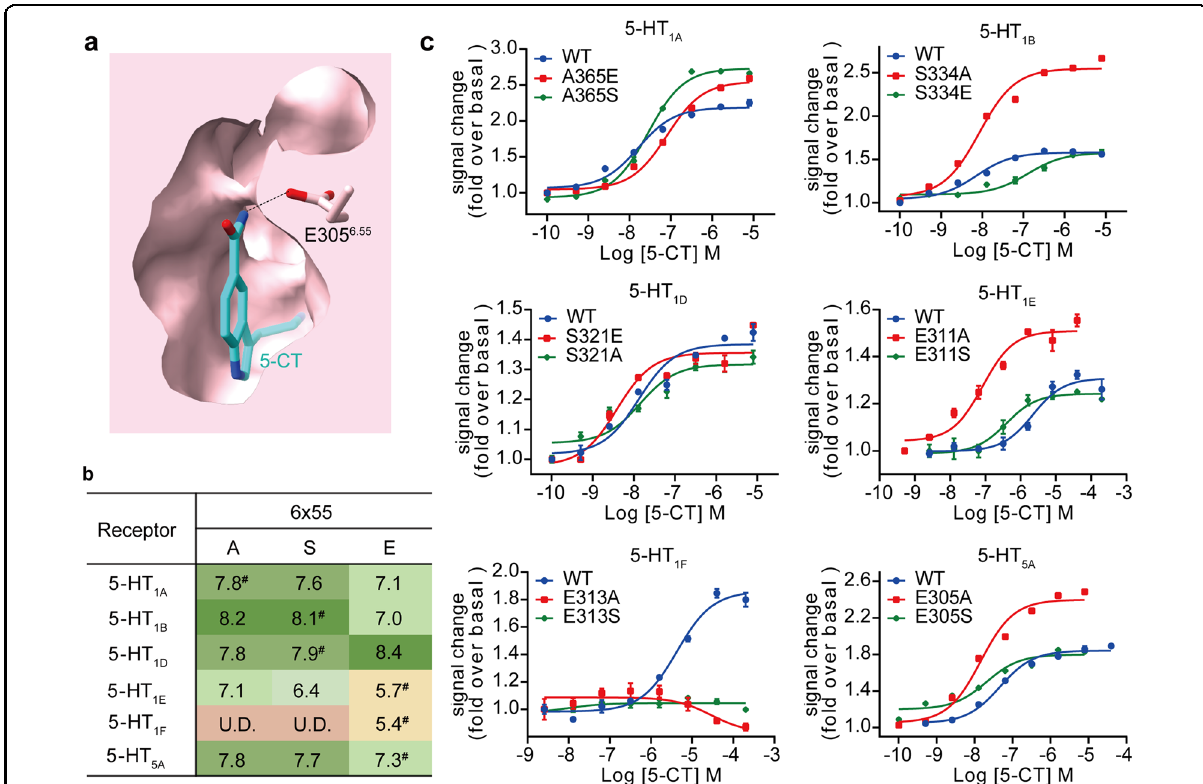
Fig. 3 Role of the residue at 6.55 in determining 5-CT selectivity of G i/o -coupled 5-HT receptors. a Cross-section of the orthosteric binding pocket of 5-HT 5A . The hydrophobic interaction between 5-CT and E305 6.55 is indicated as a black dashed line. b 5-CT activity (pEC 50 values) for wild- type (WT) and mutants of G i/o -coupled 5-HT receptors. # 5-CT activity (pEC 50 values) for WT receptors. U.D., undetectable. c Effects of mutations at 6.55 on 5-CT-induced G i protein recruitment of G i/o -coupled receptors. Three independent NanoBiT assays in triplicates were performed. Each data point presents mean ± SEM from a representative